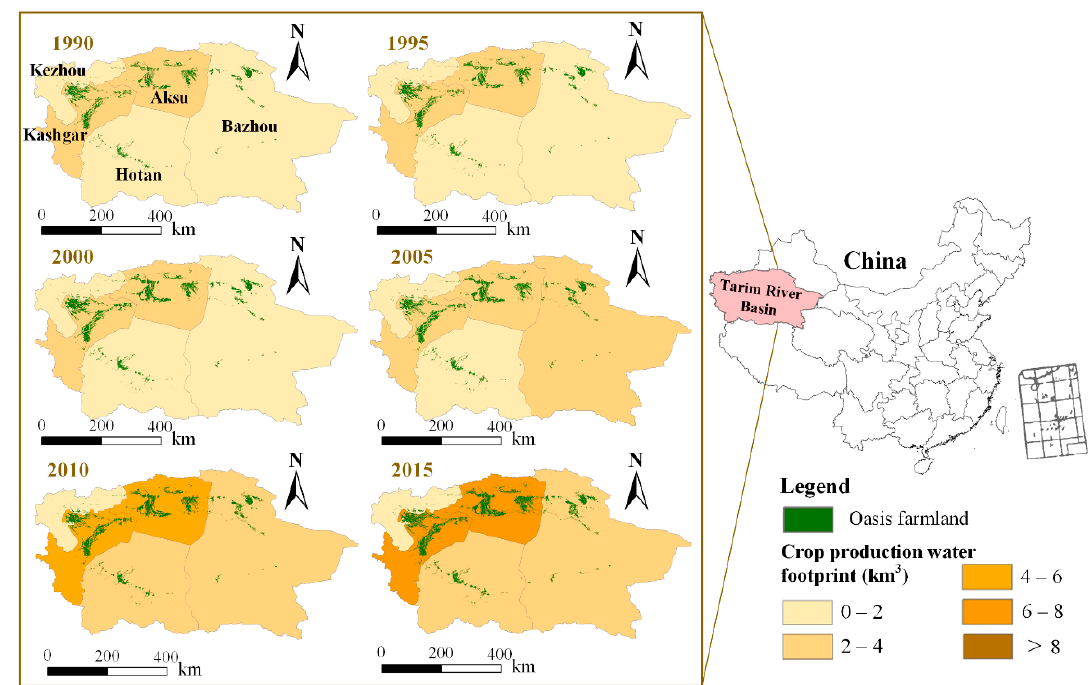
Figure 1. Location, crop production water footprint and oases of the study basin.